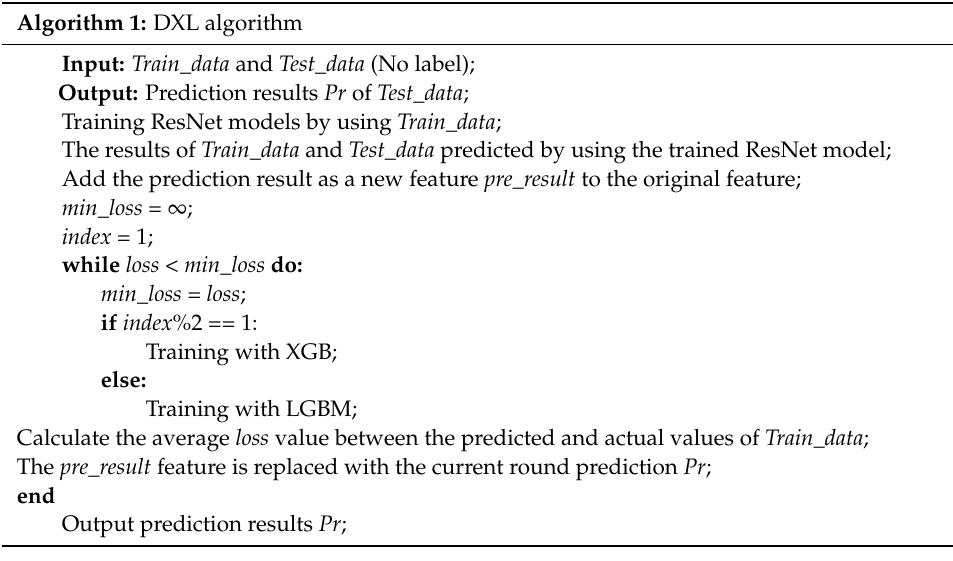
Algorithm 1: DXL algorithm